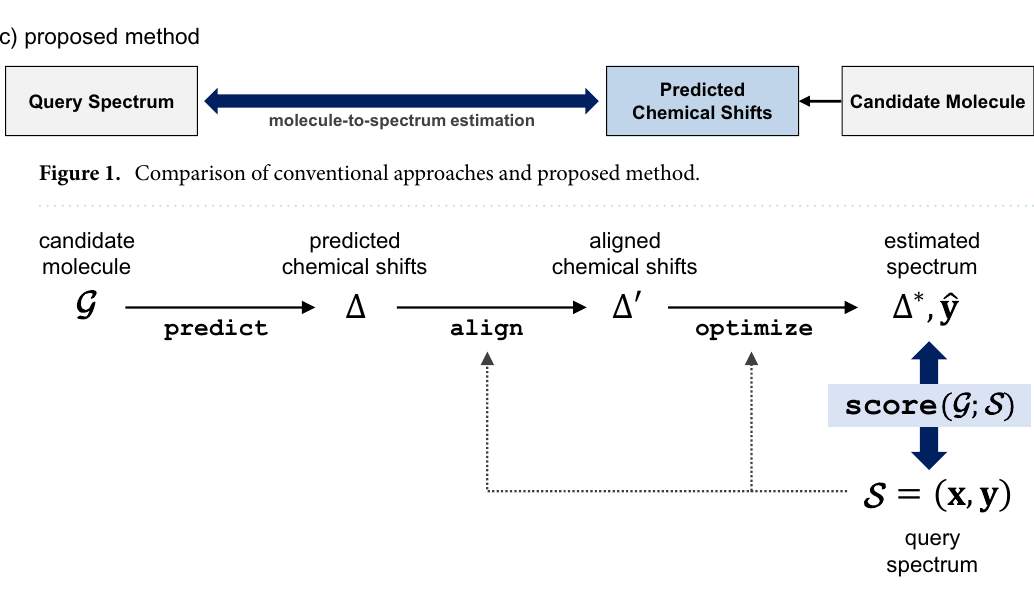
Figure 2. Illustration of molecule-to-spectrum estimation